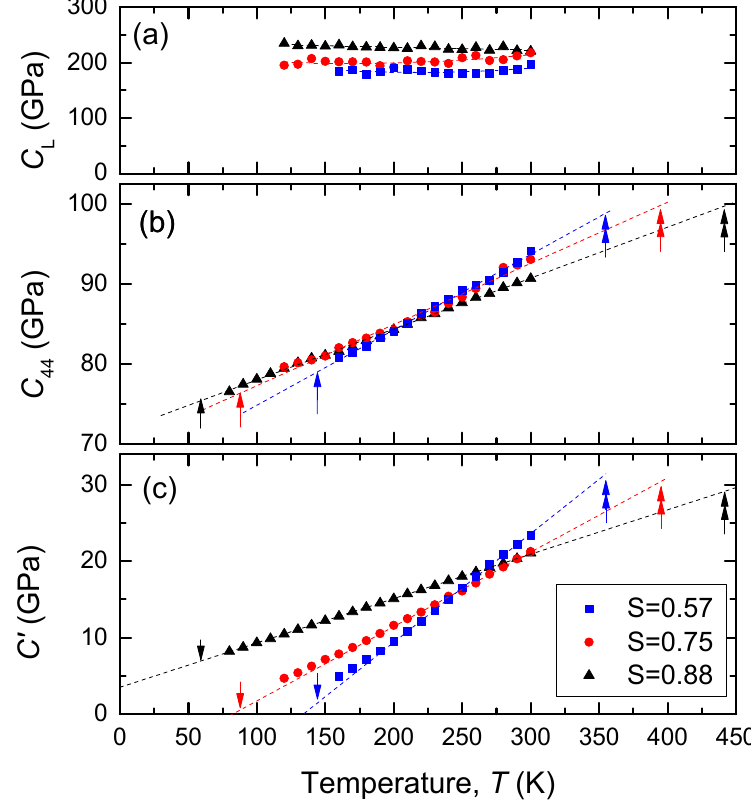
Figure 2. Elastic constants C L ( a ), C 44 ( b ) and C ’ ( c ) of Fe 3 Pt with different degrees of order S . Single arrows indicate the martensitic transformation start temperature. Double arrows indicate the Curie temperature.